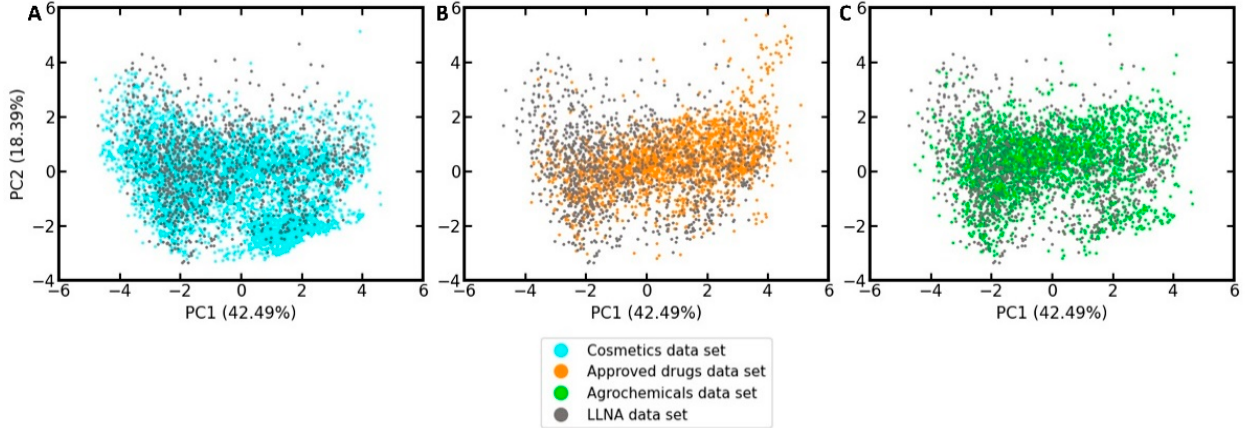
Figure 3. PCA quantifying the coverage of the LLNA data by the reference sets of ( A ) cosmetics, ( B ) approved drugs, and ( C ) agrochemicals in the feature space of the 10 selected bioactivity descriptors. The percentages in parentheses report the variance explained by the respective principal component (PC).